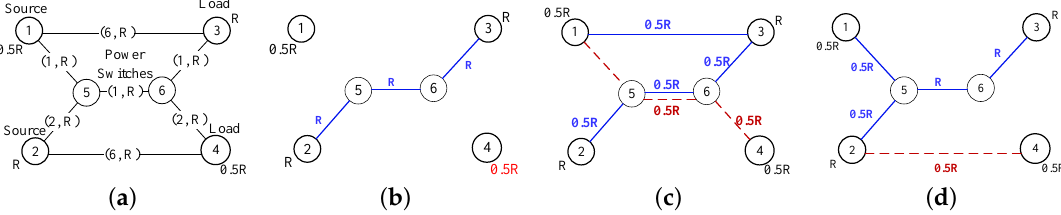
Figure 2. Example of problem definition of source and path selection on a small digital microgrid (DMG) model: ( a ) network model with paths, two sources and two loads; ( b ) Low cost path but unsatisfied requests. Total cost is 4R; ( c ) satisfied requests but high routing cost. Total cost is 7R; and ( d ) Lowest cost path and satisfied requests. Total cost is